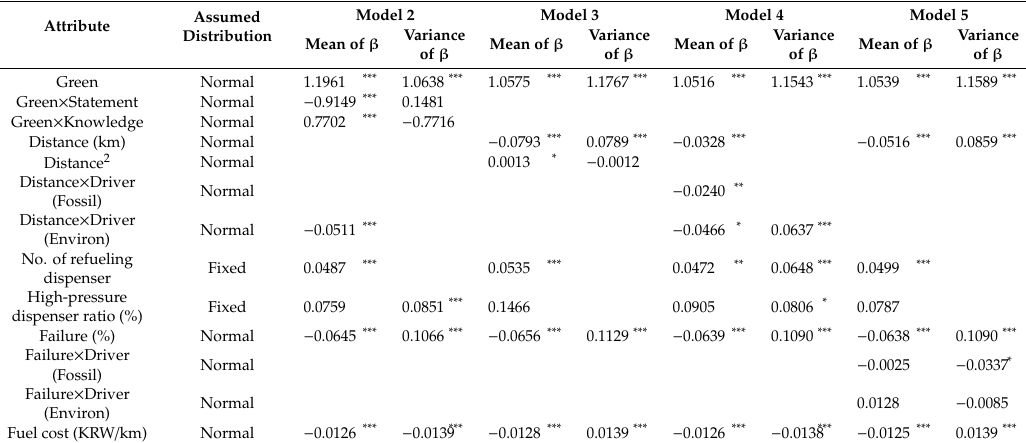
Table 4. Estimation results of mixed logit model for hydrogen refueling station (interaction